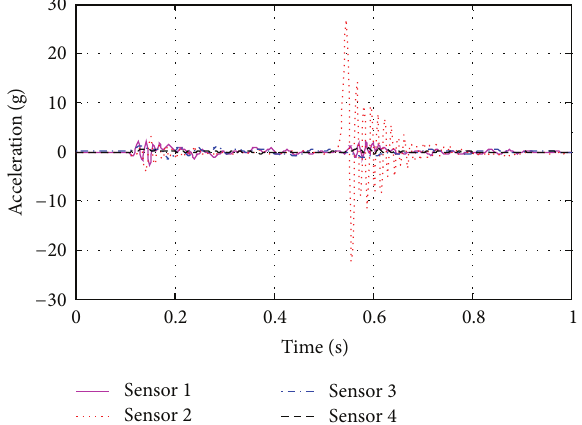
Figure 12: Accelerations with 𝑉 𝑦 = 0.41 m/s, 𝑉 𝑥 = 0 m/s, and 𝜃 = 10 ∘ .